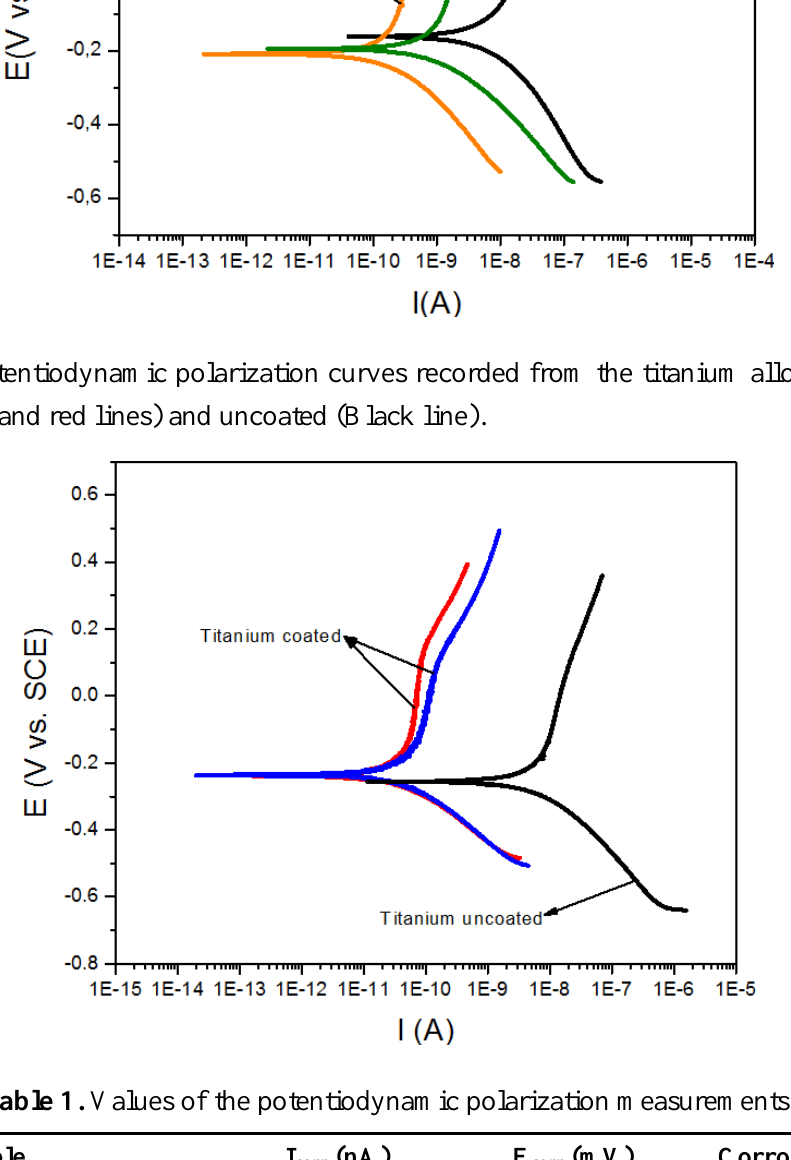
Figure 8. Potentiodynamic polarization curves recorded from stainless steel 316L coated (green and orange lines) and uncoated (Black line).